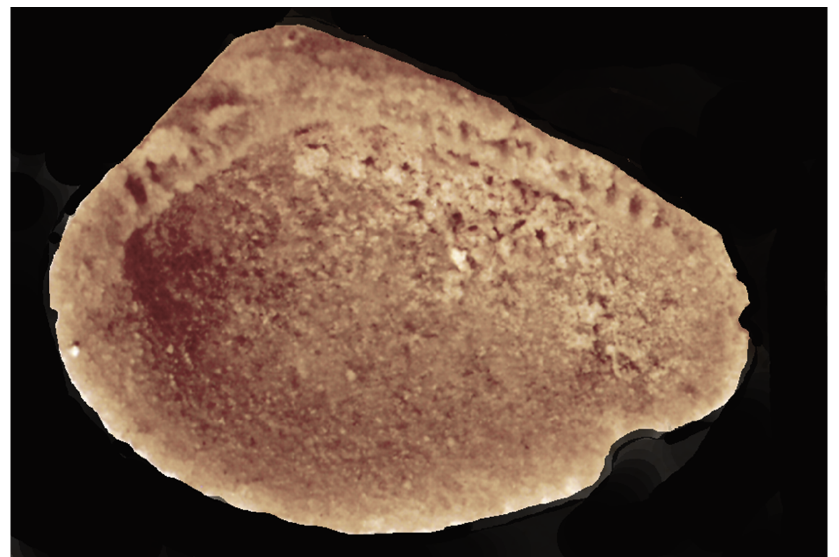
Figure 4. Nuculanoid clam fossil (IGM 5010a). Interior view of left valve, showing taxodont dentition. Greatest dimension of shell: 7 mm.